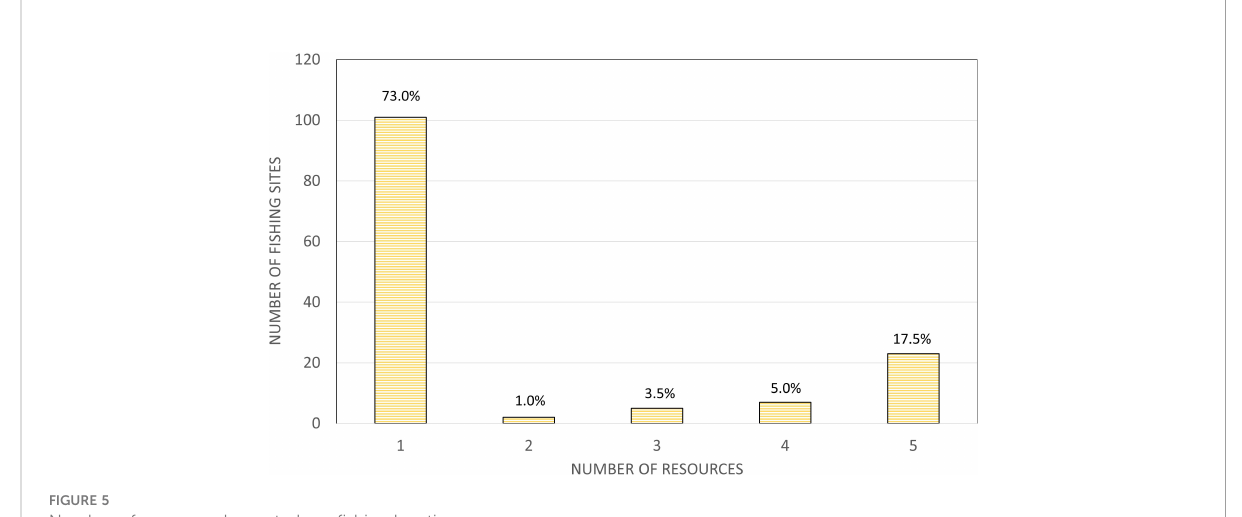
FIGURE 5 Number of resources harvested per fi shing